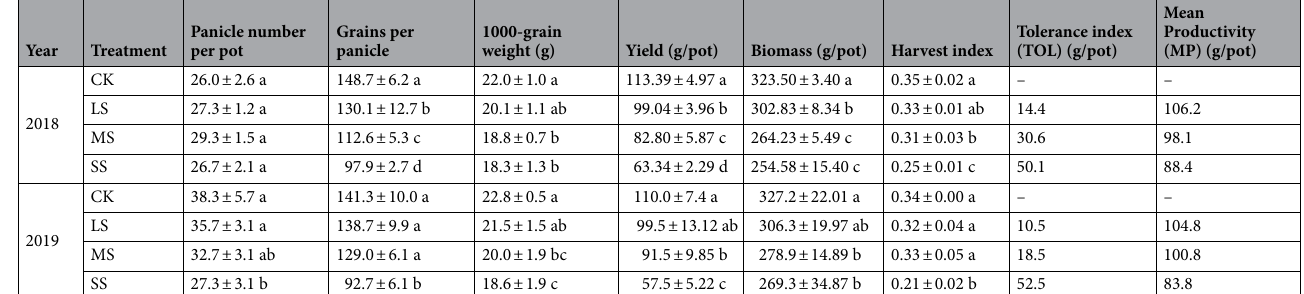
Table 3. Effects of drought stress on yield component, yield and biomass of naked oats. Different letters above the columns indicate significant differences ( P < 0.05) determined by a Duncan’s test between treatments. The same letters above the error bars indicate that there was no significant difference at P >